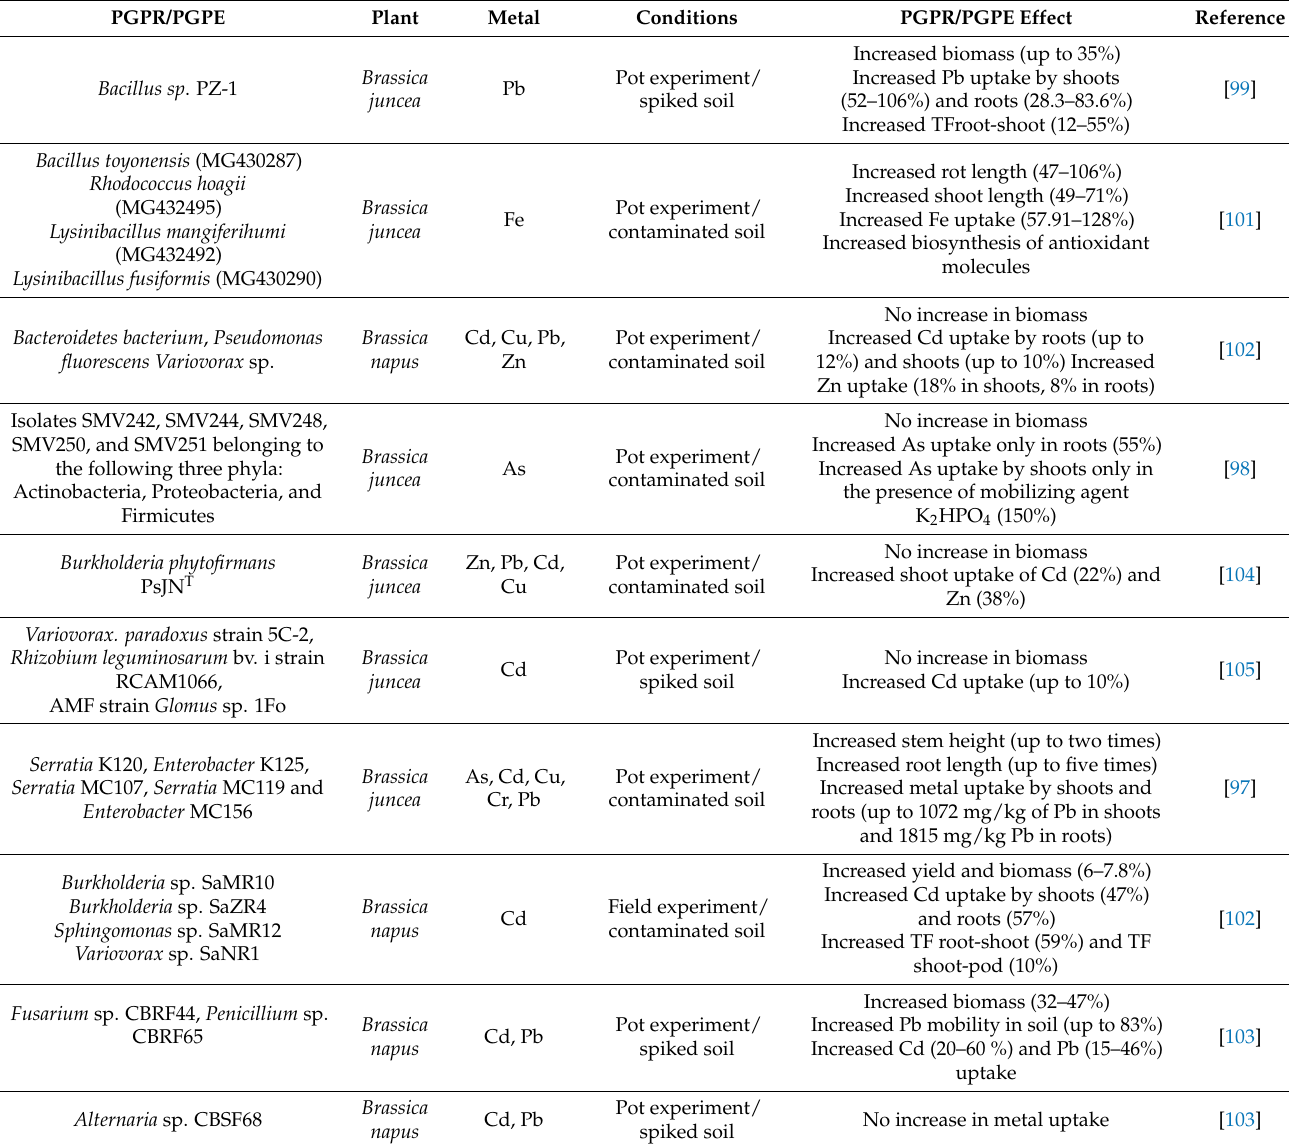
Table 1. Examples of PGPR/PGPE application in phytoremediaton with Brassica